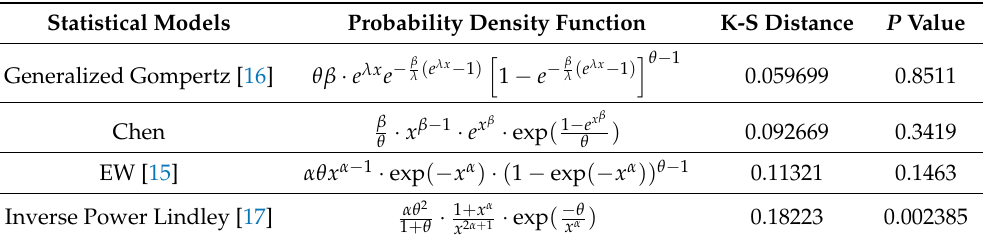
Table 9. The results of Kolmogorov-Smirnov (K-S) test for alternative statistical models. Statistical Models Probability Density Function Generalized Gompertz [16]